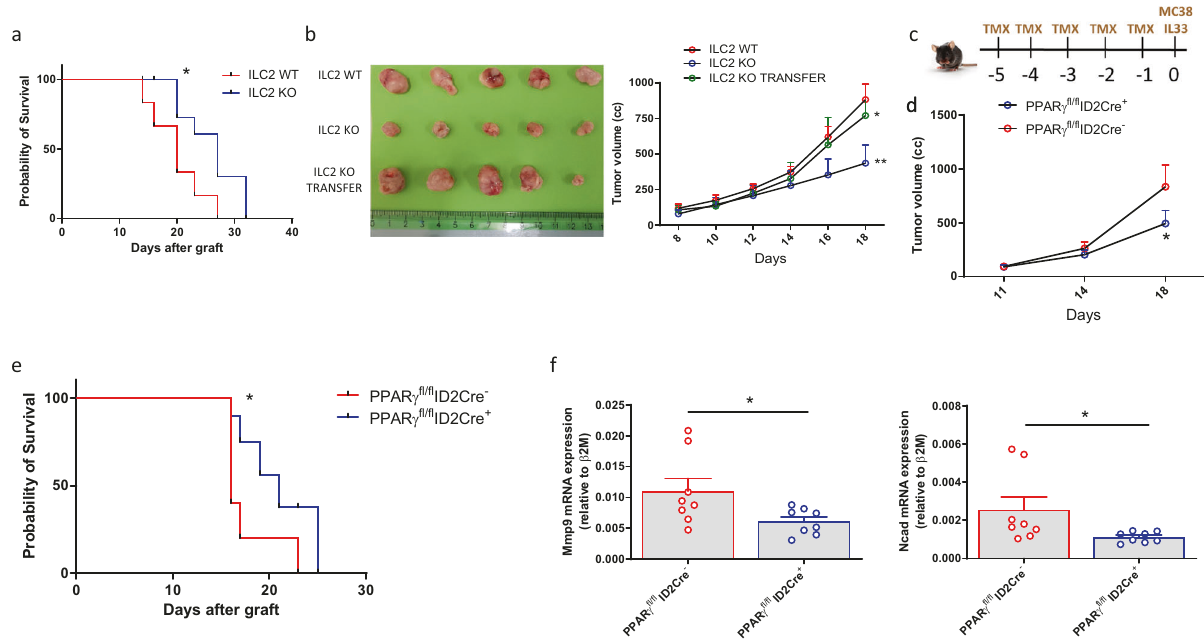
Fig. 7 PPAR γ expression in ILC2s in fl uences cancer progression in a CRC murine model. a Tumor survival of RORa fl /sg Il7r Cre positive (blue bar) or negative (red bar) mice after implantation of MC-38-IL33 murine CRC cells (ILC2 WT n = 6, ILC2 KO n = 7; * P = 0.0227). b Representative image of tumor size (left) and tumor development (right) expressed as tumor volume in ILC2 WT (open red circle), ILC2 KO (open blue circle) and ILC2 KO mice ILC2-transferred (open green circle) ( n = 6; * P = 0.0473, ** P = 0.0023). c Schematic representation of CRC murine model in Pparg fl / fl Id2 CreER T2 mice. d Tumor development expressed as tumor volume in Pparg fl / fl Id2 CreER T2 positive (open blue circle) or negative mice (open red circle) ( n = 15; * P = 0.0451). e Survival of Pparg fl / fl Id2 CreER T2 positive (blue bar) or negative (red bar) tumor-bearing mice ( n = 5; * P = 0.0338). f Expression of Mmp9 (left) and Ncad (right) assessed by qPCR analysis in Pparg fl / fl Id2 CreER T2 positive (open blue circle) or negative (open red circle) dissociated tumor tissues ( n = 8; Mmp9 * P = 0.0379, Ncad *P = 0.0104). Each symbol represents one individual mouse or sample. Data are shown as mean ± SEM and were analyzed